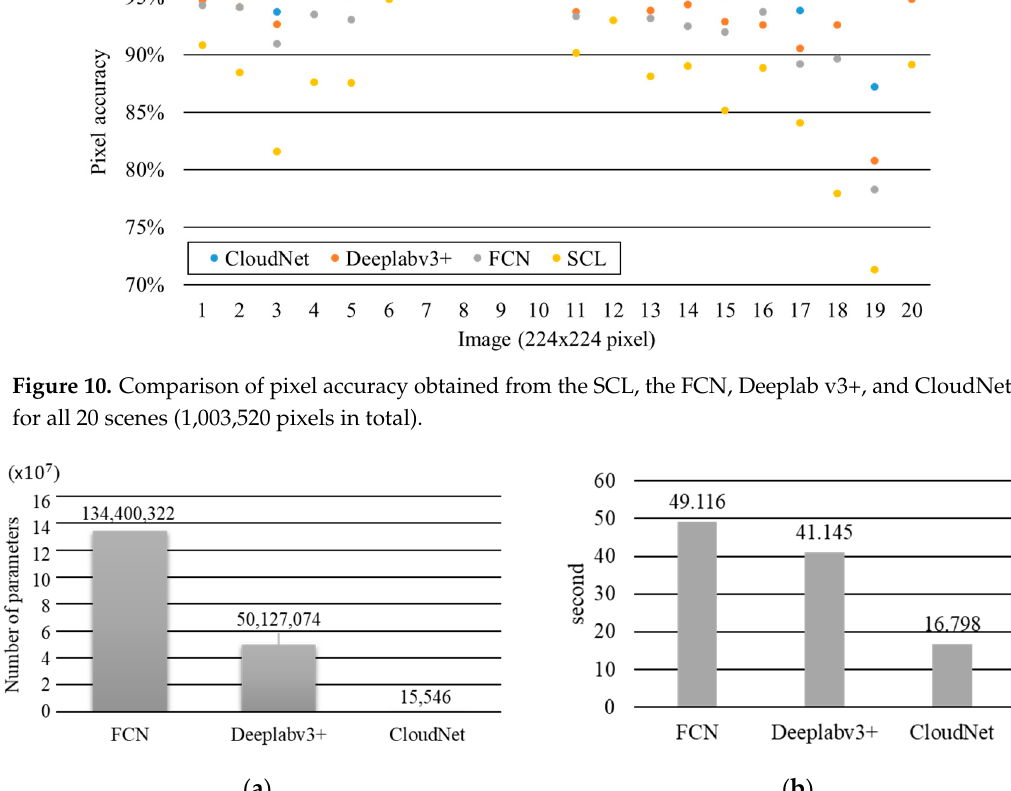
Figure 10. Comparison of pixel accuracy obtained from the SCL, the FCN, Deeplab v3+, and CloudNet for all 20 scenes (1,003,520 pixels in total).